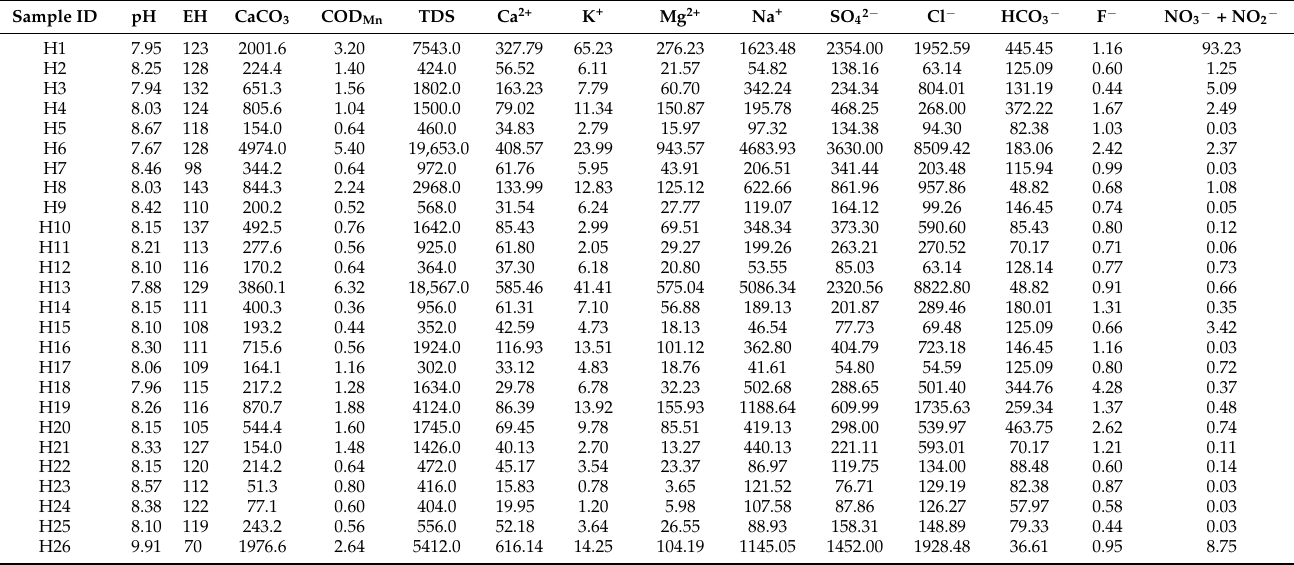
Table A1. Sample test